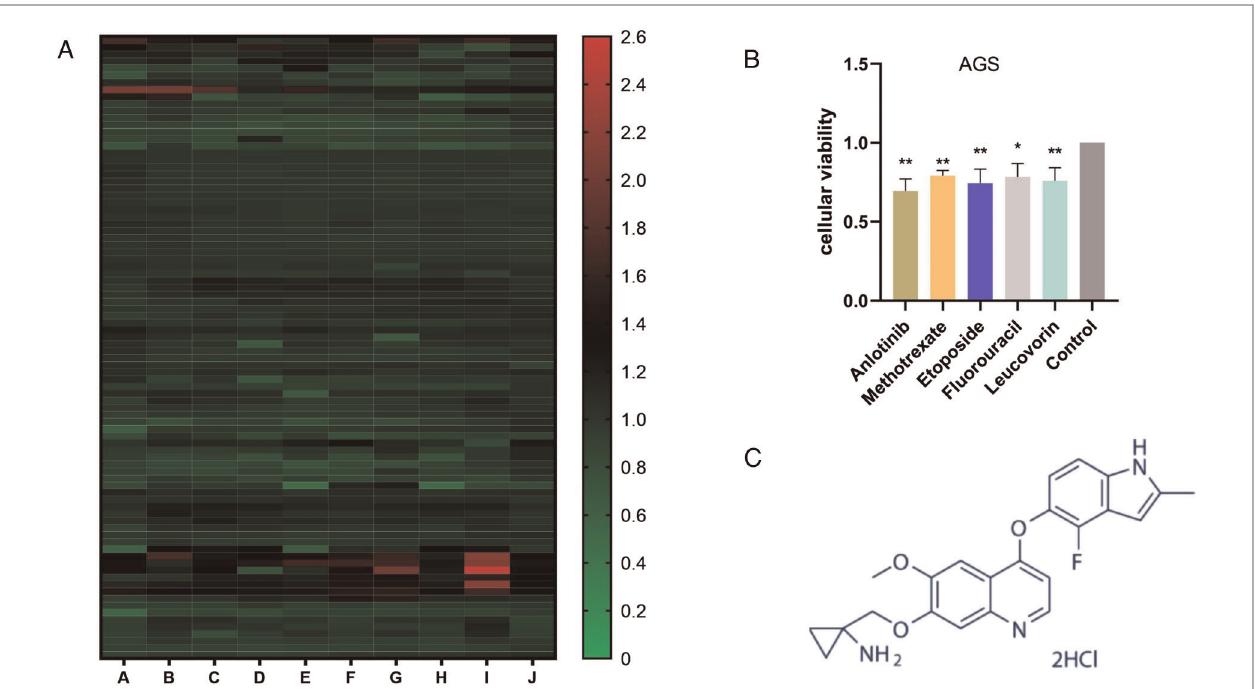
FIGURE 1 | Screening of the inhibitory effects of multiple drugs on GC cells: ( A ) The proliferation of more than 880 drugs after treatment of GC cells. ( B ) Compared with the four drugs commonly used in GC chemotherapy, Anlotinib has a more obvious inhibitory effect on the proliferation of GC cells. ( C ) Anlotinib compound structure. (Picture from www.selleck.cn). * P <0.05; ** P